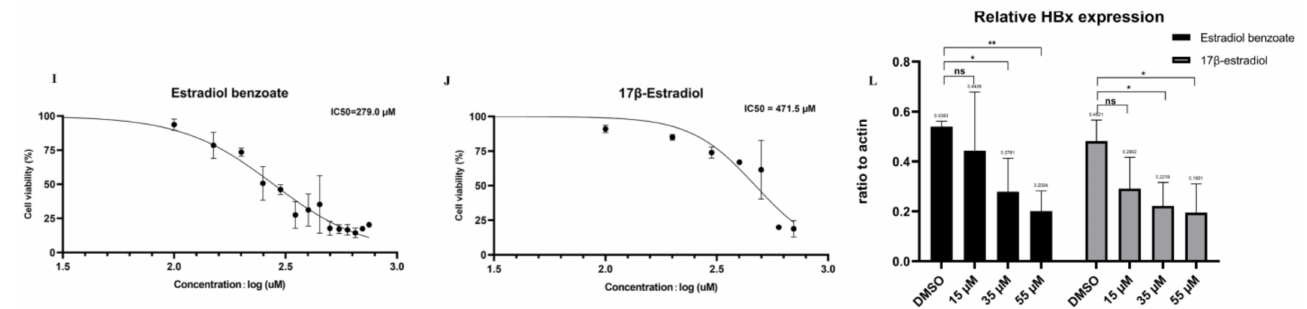
Figure 1. ( A ) Map of pSBtetHx plasmid. TRE: Tet-responsive promotor, HyGr: hygromycin. ( B ) Drug screening diagram drawn by Figdraw (www.figdraw.com, accessed on 30 April 2022). ( C ) Verifi- cation of HiBiT-X6 plasmid and pSBtetHX-6 plasmid in Huh7 cells by Western blot two days after transfection. The pSBtetHX-6 plasmid was divided into a Dox (1 µ g/mL) treatment group and the blank group. ( D ) Upper panel (scale 10 × ): cells without plasmid transfection, lower panel (scale 10 × ): single-cell clone. ( E ) Expression of HBx from SBHX21 cell line with or without Dox treatment. ( F ) Luminescence results of SBHX21 with or without Dox treatment. ( G , H ) Luminescence results of estradiol benzoate and 17 β -estradiol. Half-maximal inhibitory concentration (IC50) of estradiol